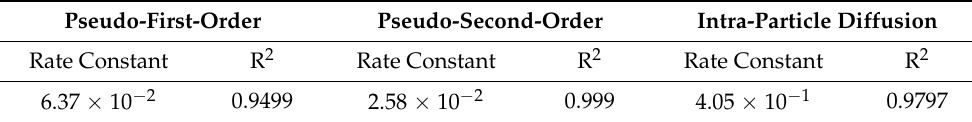
Table 6. Parameters for kinetic and intra-particle diffusion